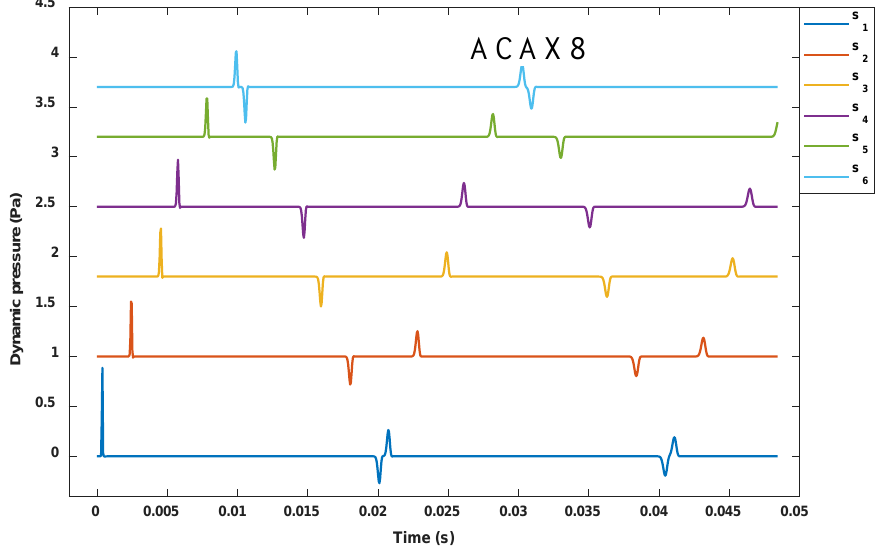
to on intact air–filled 𝑟𝑟 1 𝑟𝑟 6